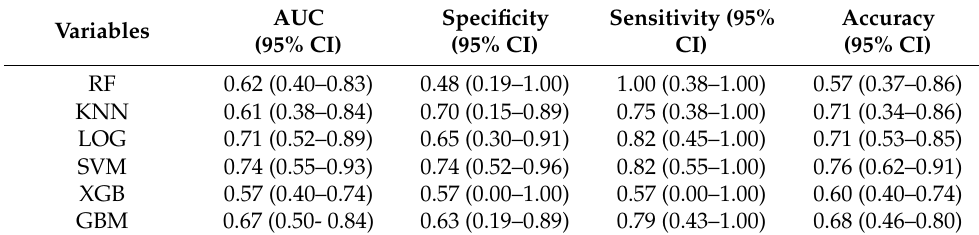
Figure 4. ROC curve of six machine-learning methods in k-folding set. A reference line indicated the AUC of 0.5. Table 2. Performance of the six models at the best threshold in the k-fold set.